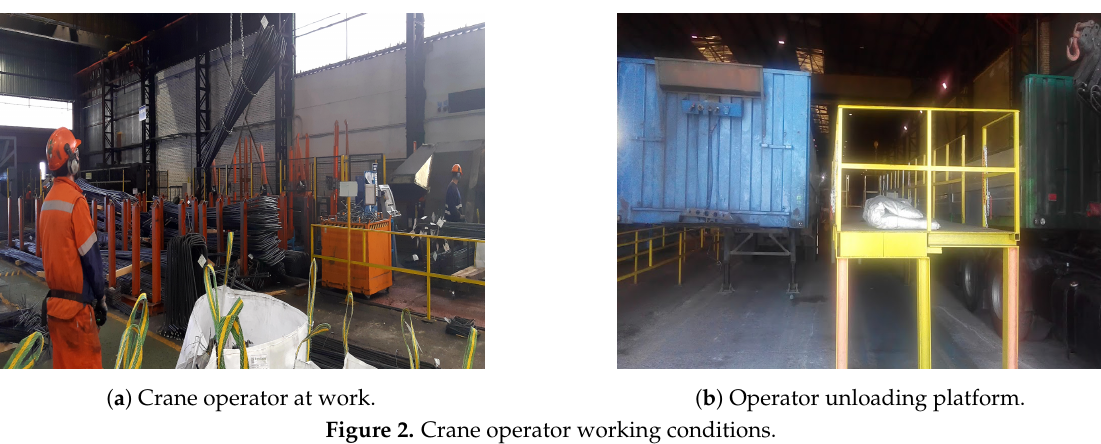
Figure 2. Crane operator working